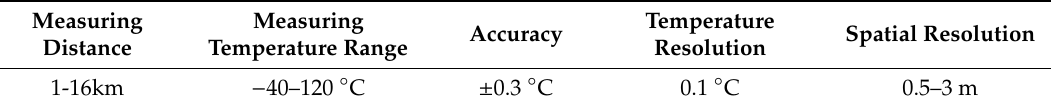
Table 3. Basic parameters of used DTS